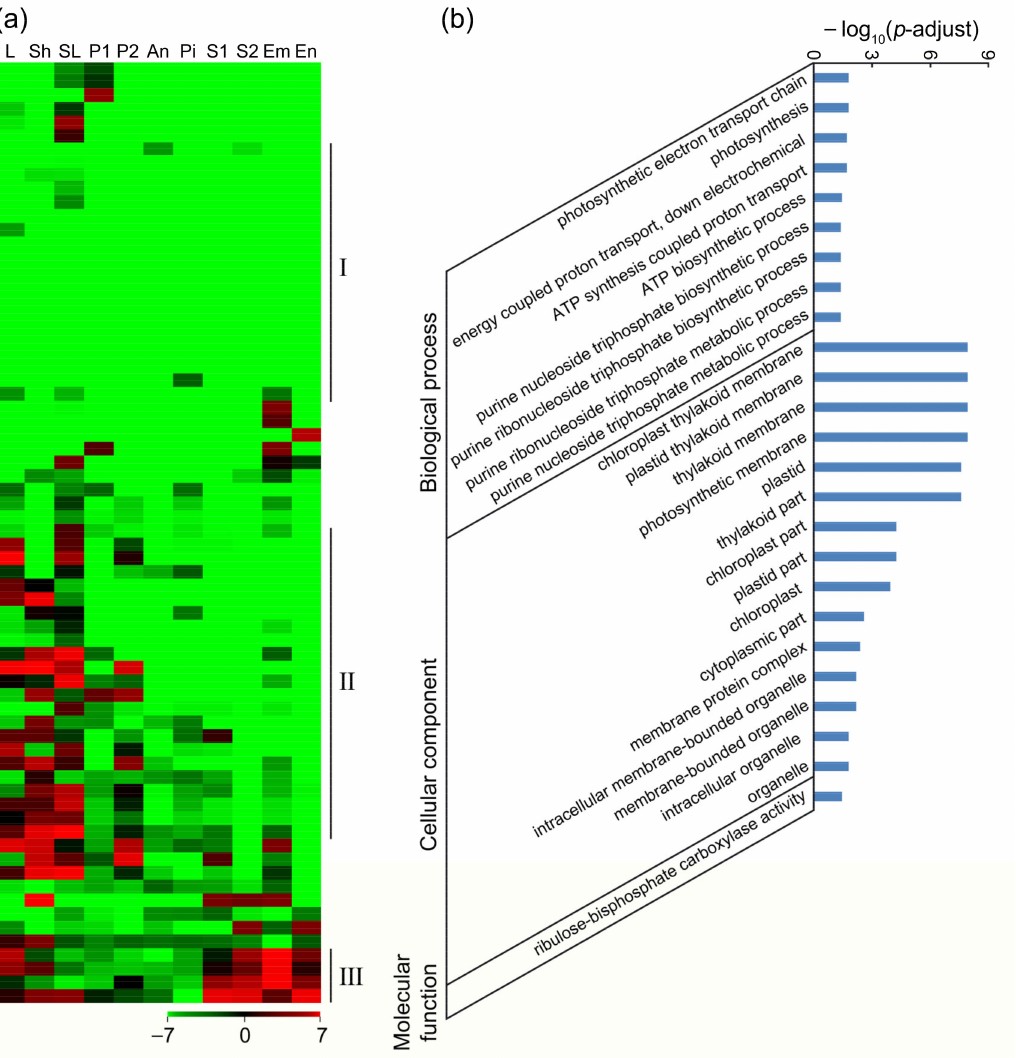
Figure 5. Analysis of the 69 genes (Group IV) induced by the germination or growth of pollen tubes in rice. Heat map ( a ) and GO enrichment analysis ( b ) of the 69 genes induced by the germination or growth of pollen tubes. L, 20-day-old leaf; Sh, 14-day-old seedling on the ground (shoot); SL, seedling at four-leaf stage; P1, panicle before emerging from the sheath of the flag leaf; P2, panicle after emerging from the sheath of the flag leaf; An, mature anther; Pi, mature pistil before pollination; S1, seed at 5 DAP; S2, seed at 10 DAP; Em, embryo at 25 DAP; En, endosperm at 25